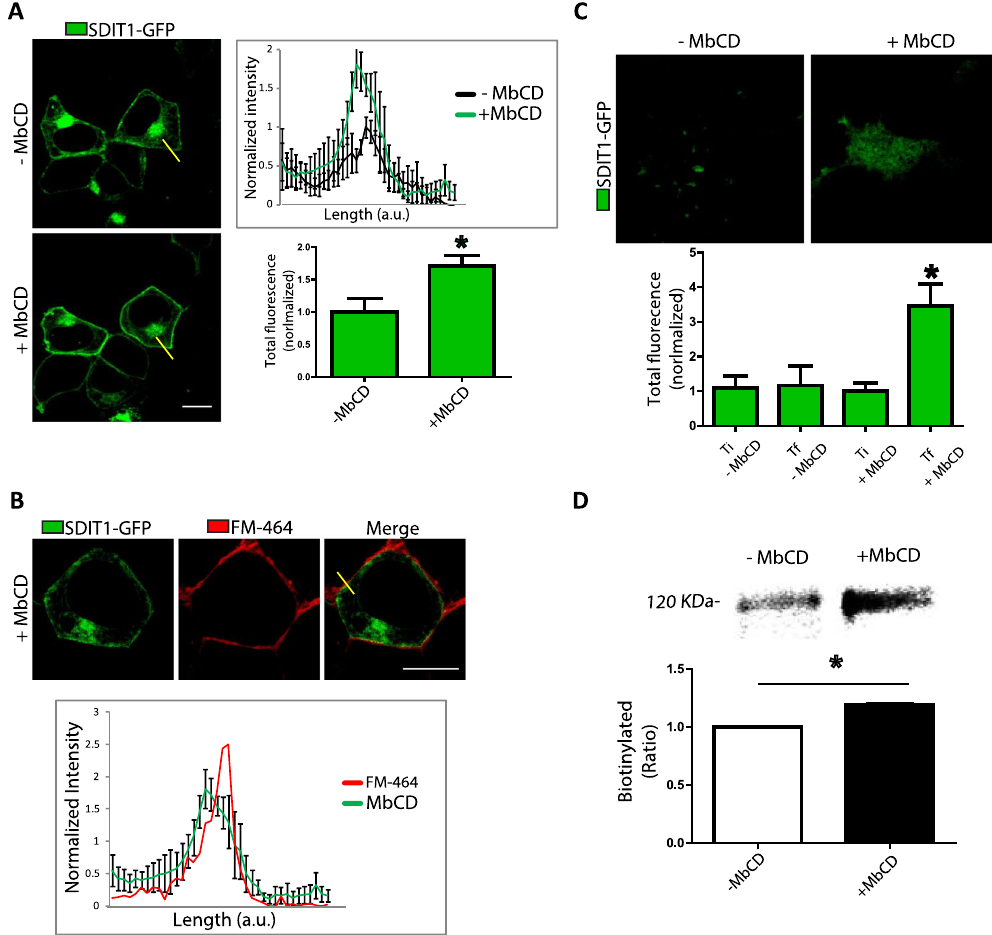
Figure 3. Cholesterol reduction induces the relocalization of SIDT1 to the plasma membrane. ( A ) SIDT1- GFP localization observed by confocal microscopy in HEK293 cells. The yellow line indicates the line where fluorescence was measured to detect the intensity levels of SIDT1-GFP before and after methyl beta cyclodextrin (M β CD) treatment for 40 minutes. The right panel shows the fluorescence intensity along the line before and after M β CD. Data shows mean ± standard deviation from at least 40 independent cells. Length plotted in arbitrary units (a.u.). Lower right panel shows the mean ± standard deviation as normalized fluorescence (1 is the before M β CD condition). Scale bar: 10 microns. ( B ) Co-localization of SIDT1-GFP The lower panel shows the mean ± standard deviation of normalized fluorescence intensity obtained from at least 40 independent experiments. Data shows initial recording time (Ti) and final recording time (Tf). Notice that Ti and Tf do not change in cells not exposed to M β CD. ( D ) Biotinylation analysis of SIDT1-GFP before and after M β CD treatment. The lower panel shows the mean ± standard deviation of biotinylated protein obtained from measuring the density of the protein bands in the gel from at least 4 independent experiments. Gels were cropped to include all conditions in a single figure and because no other bands were detected in the rest of the